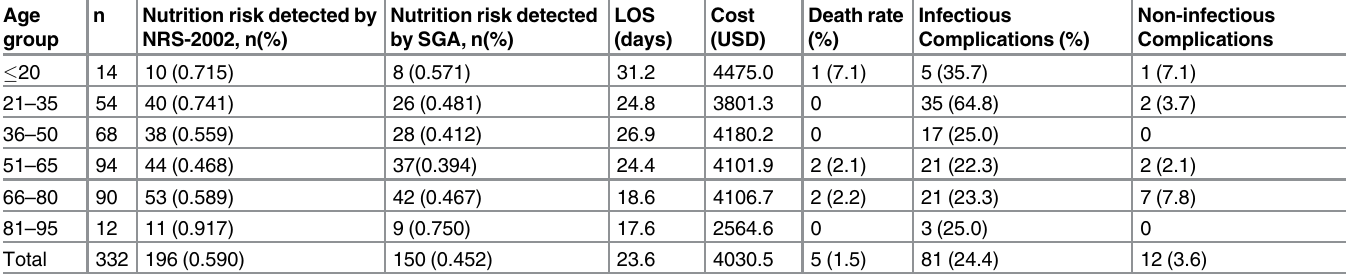
Table 1. Detailed clinical outcomes for different age